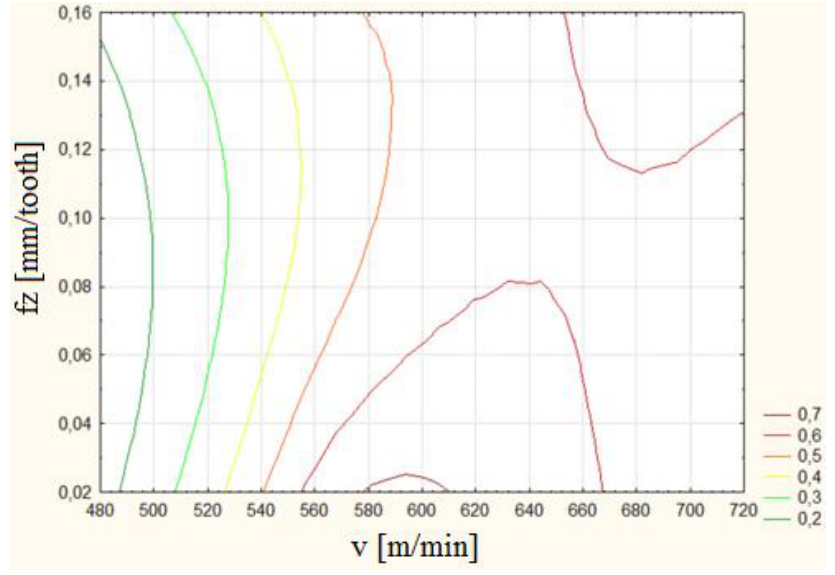
Figure 12. Indication of the spatial variation curves of R a according to v and f z .